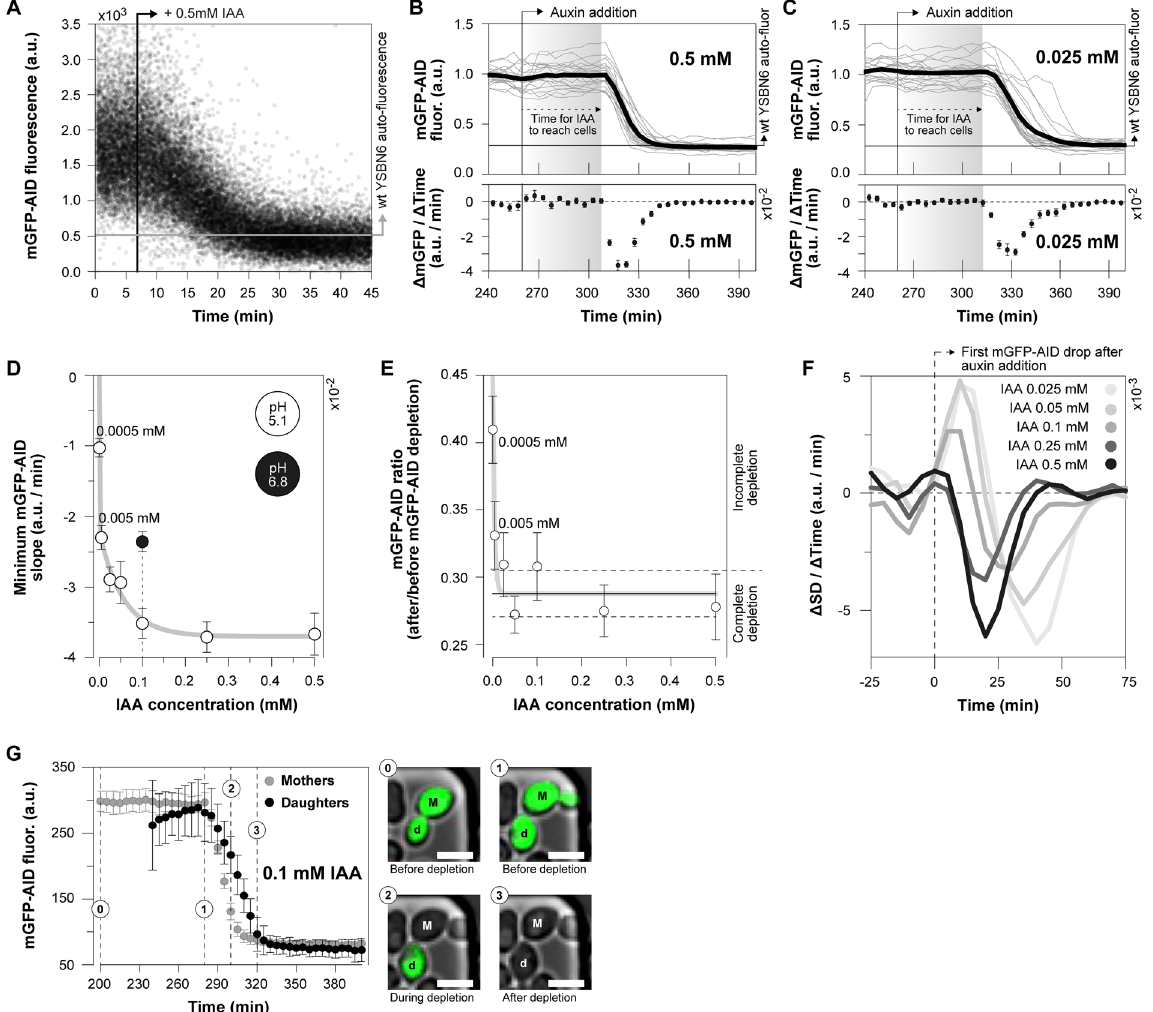
Figure 1. Auxin concentration-dependent dynamics of targeted protein depletion. ( A ) The mGFP-AID fluorescence continuously measured using flow cytometry. 0.5 mM of auxin were added at 06:50 mm:ss. Each data point corresponds to a single cell. ( B , C ) The average mGFP-AID depletion dynamics upon the addition of ( B ) 0.5 mM (20 cells) and ( C ) 0.025 mM (22 cells) auxin in the microfluidic device. Top figures: single cell (grey lines) and their average (black line) mGFP-AID trajectories. Each single cell trajectory was normalized by dividing over the mean mGFP-AID signal from 0 to 240 minutes. Bottom figures: average rate ( Δ mGFP/ Δ Time) of mGFP-AID depletion (error bars: SEM). The levels of yeast auto-fluorescence were divided over the mGFP-AID levels prior the addition of auxin to indicate the point of complete protein depletion. When we use the syringe pump for the perfusion of medium through the chip, it takes 50 ± 5 minutes for auxin to reach the cells after the switch. This lag time is indicated. ( D ) The minimum mGFP-AID slope (as in Fig. 1B‚C), or the maximum rate of mGFP-AID depletion, plotted against the auxin concentration (error bars: SEM). For an auxin concentration of 0.1 mM the rate of protein depletion was measured at pH 5.1 (white marker) and pH 6.8 (black marker). A two-phase exponential decay function was fitted to the white markers (y-intercept set to zero). Raw data, including the numbers of analyzed cells, are presented in Fig. S2A and B. (E) The completeness of protein depletion: the average mGFP-AID signal after the addition of auxin (500–740 min – as in Fig. 1B,C) was divided by the same signal before the addition of auxin (0–240 min – as in Fig. 1B,C) for each single cell and auxin concentration. The average ratios are presented and their 95% CI (error bars) reflect cell-to-cell variability. The horizontal lines correspond to the range of complete protein depletion (mean: solid line, 95% CI: dashed lines), estimated non-parametrically (bootstrapping, 100 iterations) by dividing the auto-fluorescence of wild type yeast (13 non-fluorescent cells) by the average mGFP-AID fluorescence (15 cells prior to depletion). A log(dose) response curve with a variable slope was fitted to the data (y-intercept was set to 1, base set to 0.288 – average ratio for complete depletion). ( F ) The change of the standard deviation of the mGFP-AID signal per time interval and auxin concentration reports the uniformity of the response to auxin. Positive slopes denote an increasing standard deviation and a variable response. Negative slopes denote a decrease in cell-to-cell mGFP- AID variability. ( G ) Comparison of the average mGFP-AID depletion dynamics (error bars: 95% CI) between yeast mothers (21 cells) and daughters (7 cells). Microscopy images display their different mGFP-AID depletion (scale 5 μ m, same contrast applied in all images). See also Movie